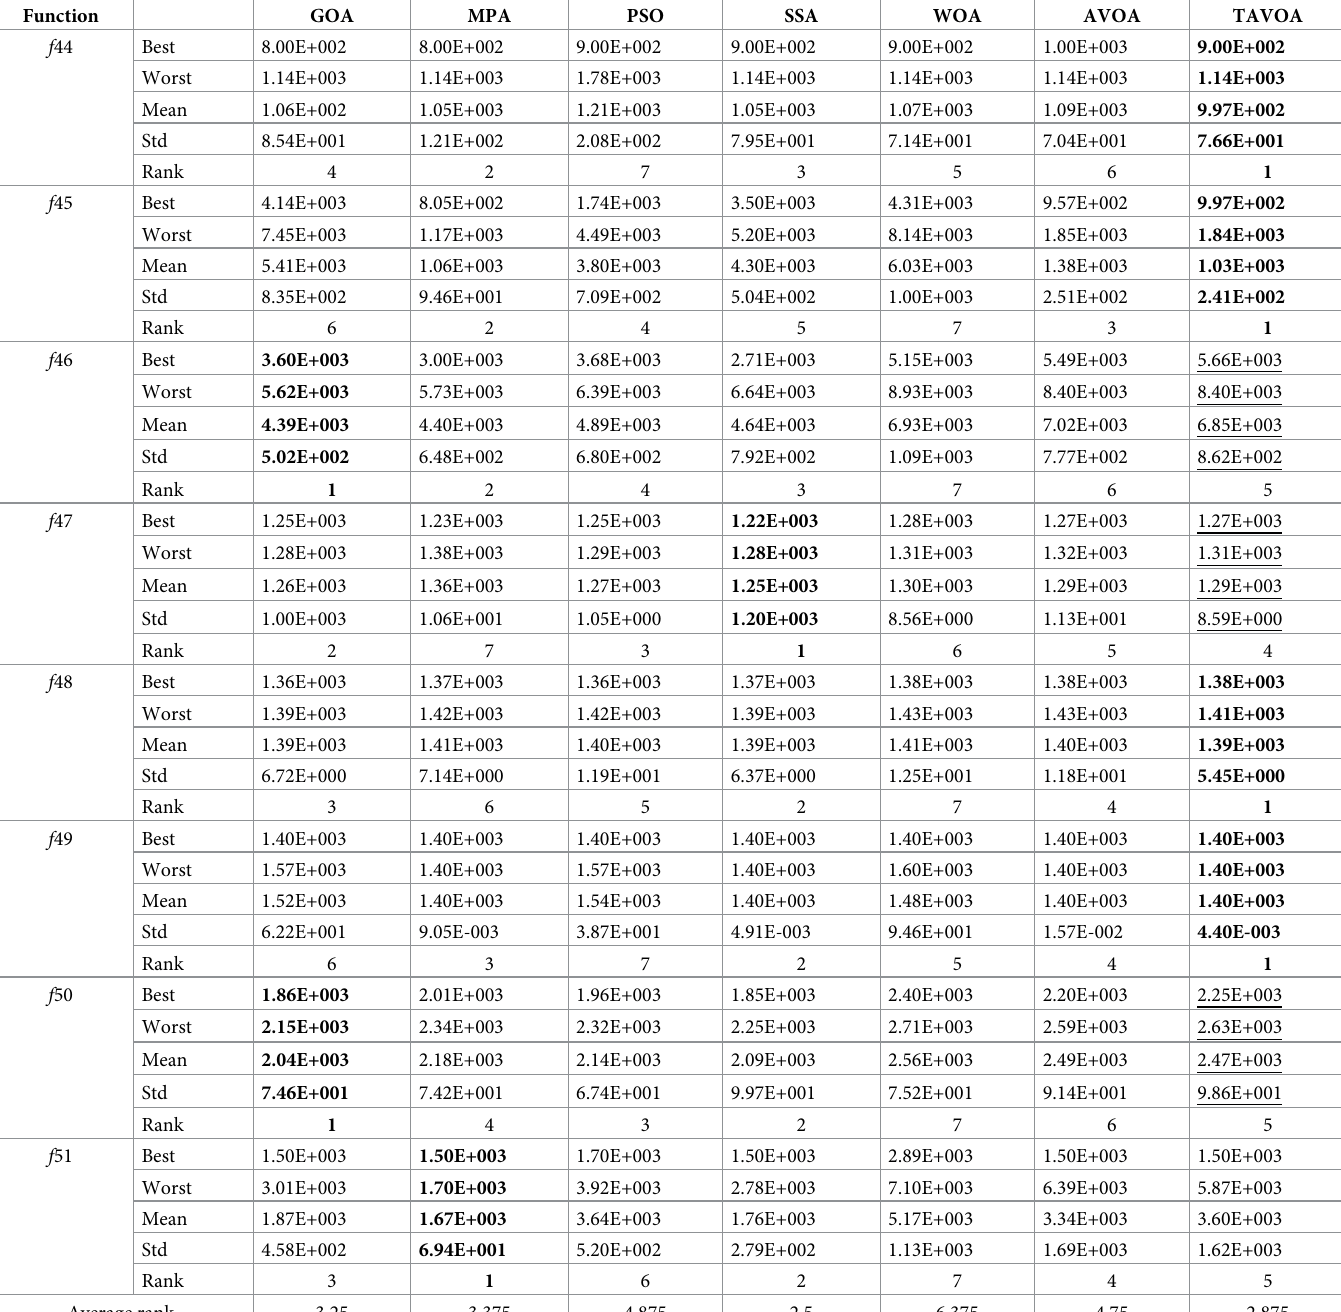
Table 10. Experimental results of CEC 2013 composition benchmark functions ( f 44 − f